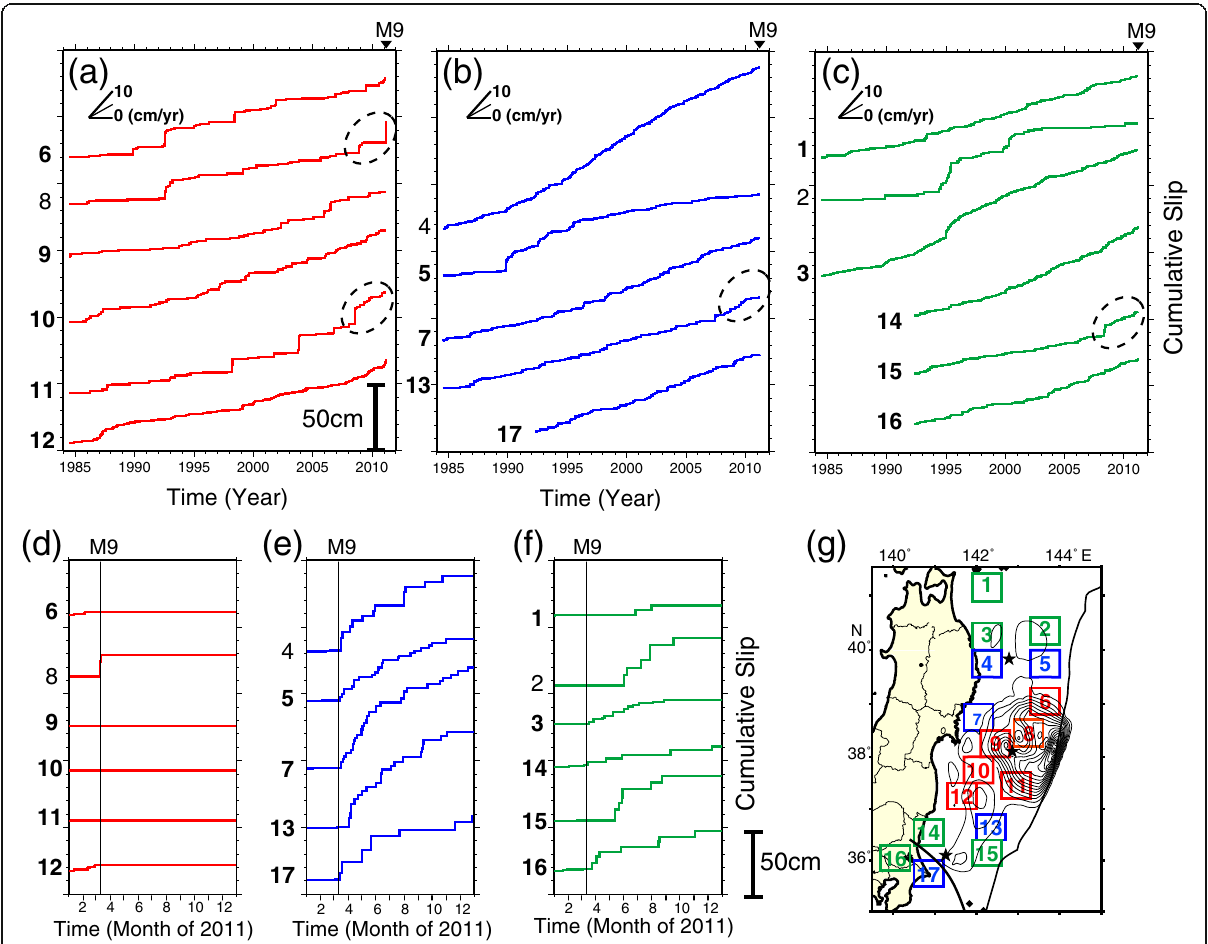
Fig. 12 Temporal evolution of slow slip in sub-regions (0.5° × 0.7°) of the plate interface along the Japan trench (after Uchida and Matsuzawa (2013)). a – c The period before the 2011 Tohoku-oki earthquake. d – f The year that includes the Tohoku-oki earthquake. The regions shown in g are categorized into areas with coseismic slip from the 2011 event with no afterslip (regions 6, 8, 9, 10, 11, and 12, in red); in the vicinity of the coseismic slip area and showing large, almost immediate slip after the Tohoku-oki earthquake (regions 4, 5, 7, 13, and 17, in blue); and areas distant from the coseismic slip showing small or delayed afterslip (regions 1, 2, 3, 14, 15, and 16). Panels a – f correspond to these categories. In g , contours show the coseismic slip distribution of the Tohoku-oki earthquake (Iinuma et al. 2012), stars show the epicenters of the 2011 Tohoku-oki earthquake and its two largest interplate aftershocks, and the thick black line shows the northeastern limit of the Philippine Sea plate in the Kanto region (Uchida et al. 2009a). Dashed ellipsoids show slip rate increases before the Tohoku-oki